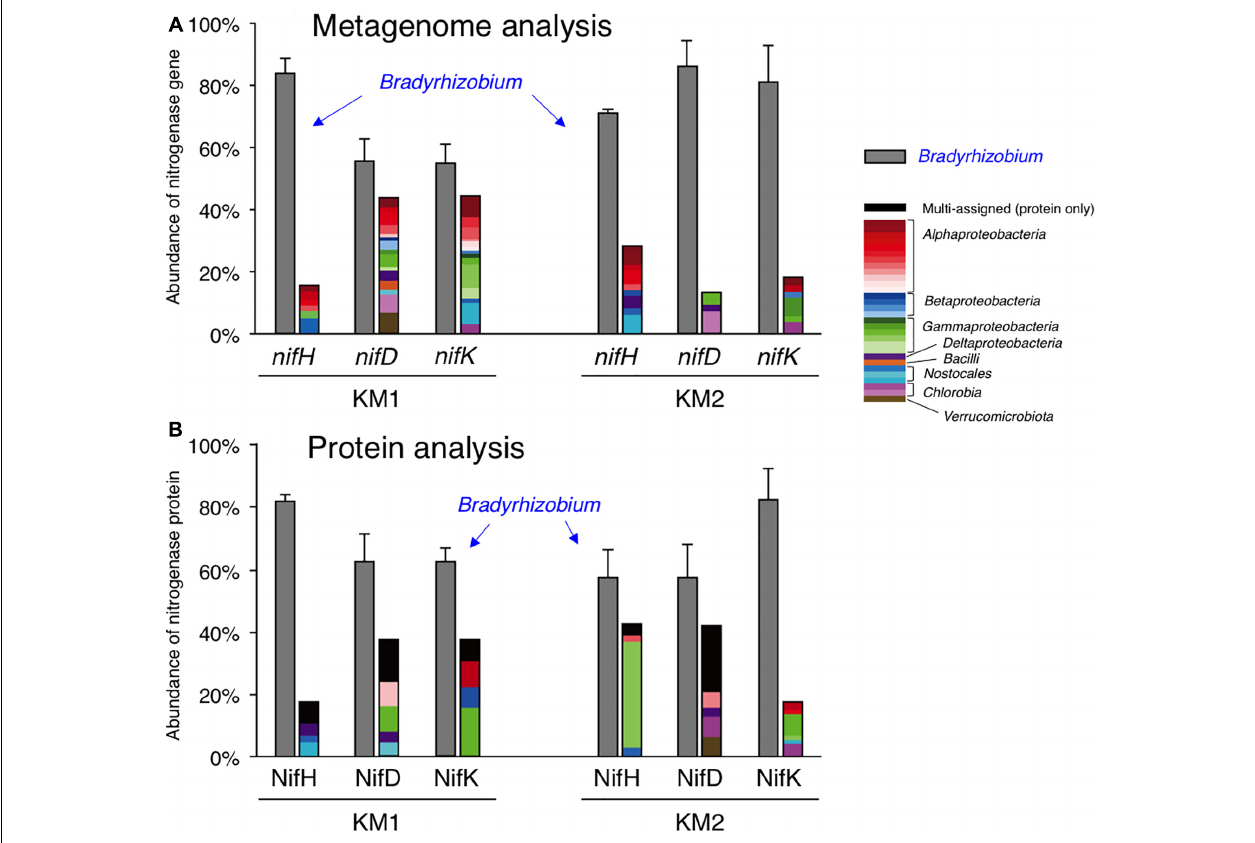
FIGURE 2 | Relative abundance of nifHDK reads (A) and NifHDK peptides (B) of respective bacterial genera. Data represent the average of three biological replications. The color of bars indicates assigned taxonomy. Gray indicates Bradyrhizobium . Black in panel B indicates multi-assigned peptides. Bar indicates standard error of three biological